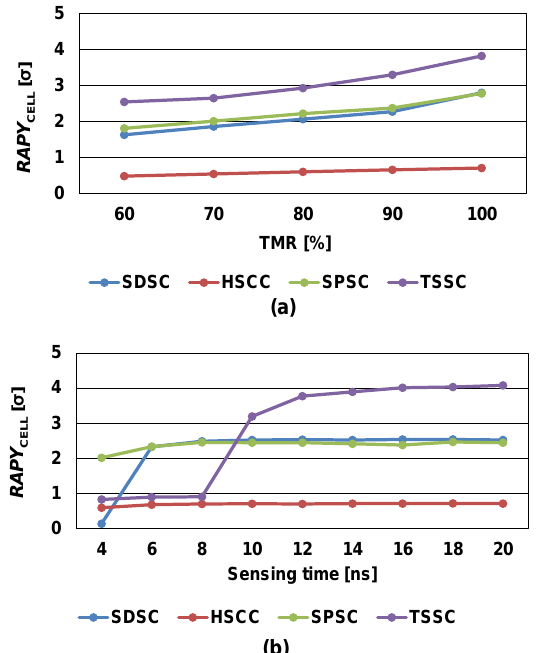
Figure 7. RAPY CELL of SDSC, HSCC, SPSC, and TSSC with respect to ( a ) TMR of MTJ and ( b ) sensing time.